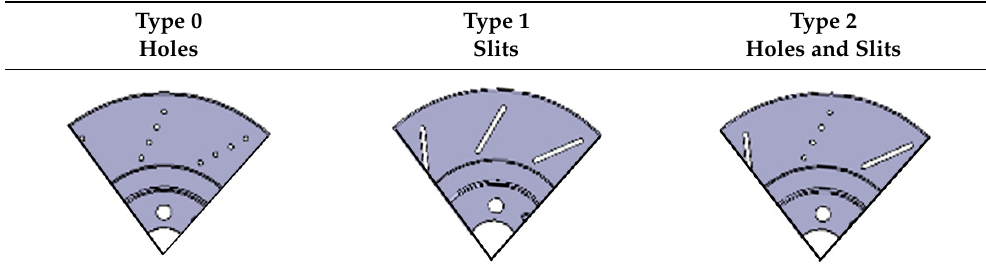
Table 4. Patterns of holes and slits.